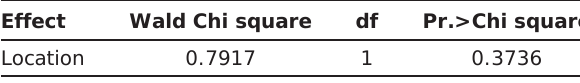
Table-1: Logistic procedure: Analyze of